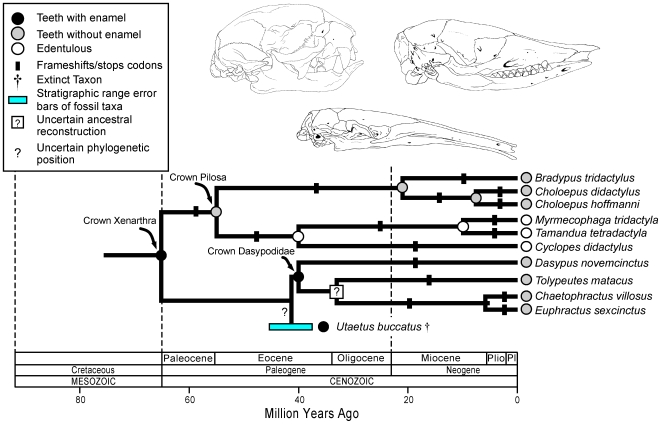
An integrated interpretation of the history of enamel degeneration in Xenarthra based on fossils, phylogenetics, molecular clocks, frameshift mutations, and dN/dS ratios.No definitive stem xenarthrans have been described, but the common ancestor of Xenarthra was reconstructed as having teeth with enamel based on (1) purifying selection on the stem xenarthran branch (ω = 0.48), (2) a reconstructed ancestral ENAM sequence that contains no frameshifts and no stop codons, (3) at least one crown-group xenarthran (Utaetus) with enamel, which would be improbable to re-evolve if the common ancestor of Xenarthra lacked enamel and had a nonfunctional copy of ENAM, and (4) genomics observations. The common ancestor of Pilosa was reconstructed as having teeth without enamel based on the occurrence of shared frameshifts in ENAM on the stem pilosan branch. The dN/dS ratio in crown clade Dasypodidae agrees with the neutral evolution (dN/dS = 1) hypothesis. There are also frameshifts that result in premature stop codons in all dasypodid ENAM sequences; however, none are shared by all four dasypodids that were sampled in our analysis. We reconstructed the ancestor of living Dasypodidae as having enamel, which may have been very thin as in Utaetus, based on the absence of shared frameshift mutations in protein-coding sequences of AMELX, AMBN, ENAM, and MMP20. The sister group relationship and divergence time between Choloepus hoffmanni and C. didactylus is based on analyses with ENAM (Figure S1, Figure S2; Methods). All other relationships and divergence times are based on Figure 1 of Delsuc et al.
[20]. Utaetus is derived from Casamayoran age deposits, which are thought to be ?middle to late Eocene in age [75],[76].